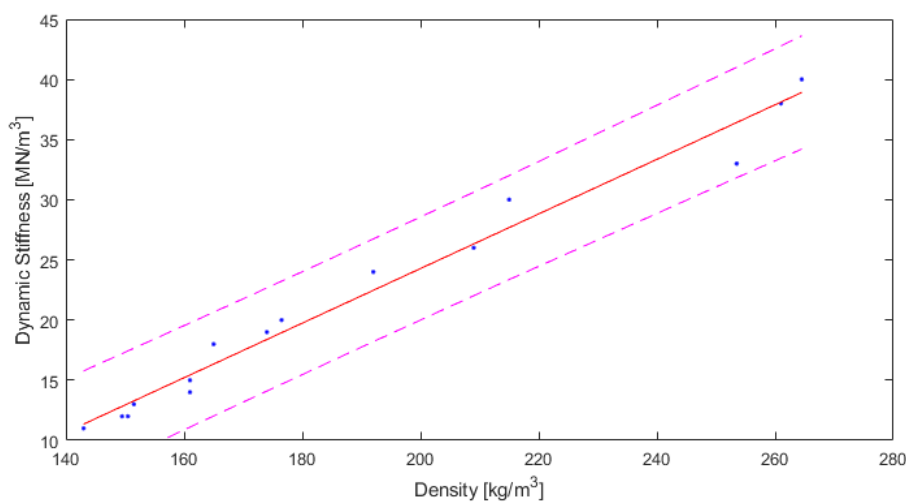
Figure 8. Results for dynamic stiffness depending on density of material, with fitted curve and 95% confidence bounds (own elaboration).